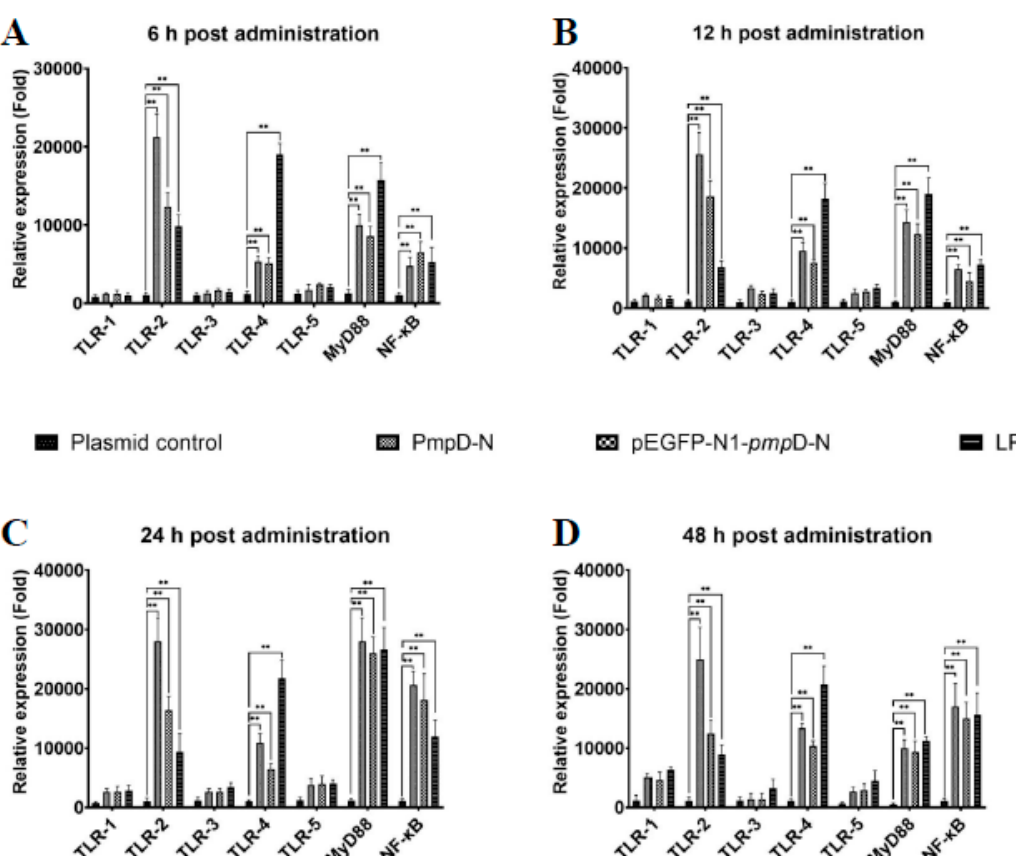
Figure 4. mRNA expression of Toll-like receptors (TLRs), myeloid di ff erentiation factor 88 (MyD88), and nuclear factor kappa B (NF- κ B) post-treatment with PmpD-N or pEGFP-N1-pmpD-N. The expression levels of TLR1–TLR5, MyD88, and NF- κ B were determined by qRT- PCR. At di ff erent time points, the cell cultures were quantified in triplicate by qRT-PCR for levels of mRNA expression of TLRs and MyD88 by antigen-stimulated and C. - psittaci -infected HD11 cells ( A ) 6 h; ( B ) 12 h; ( C ) 24 h; ( D ) 48 h. Statistical analyses were performed with one-way analysis of variance (ANOVA) with Tukey’s post hoc multiple comparisons test (** p < 0.01 when compared with the plasmid control group).